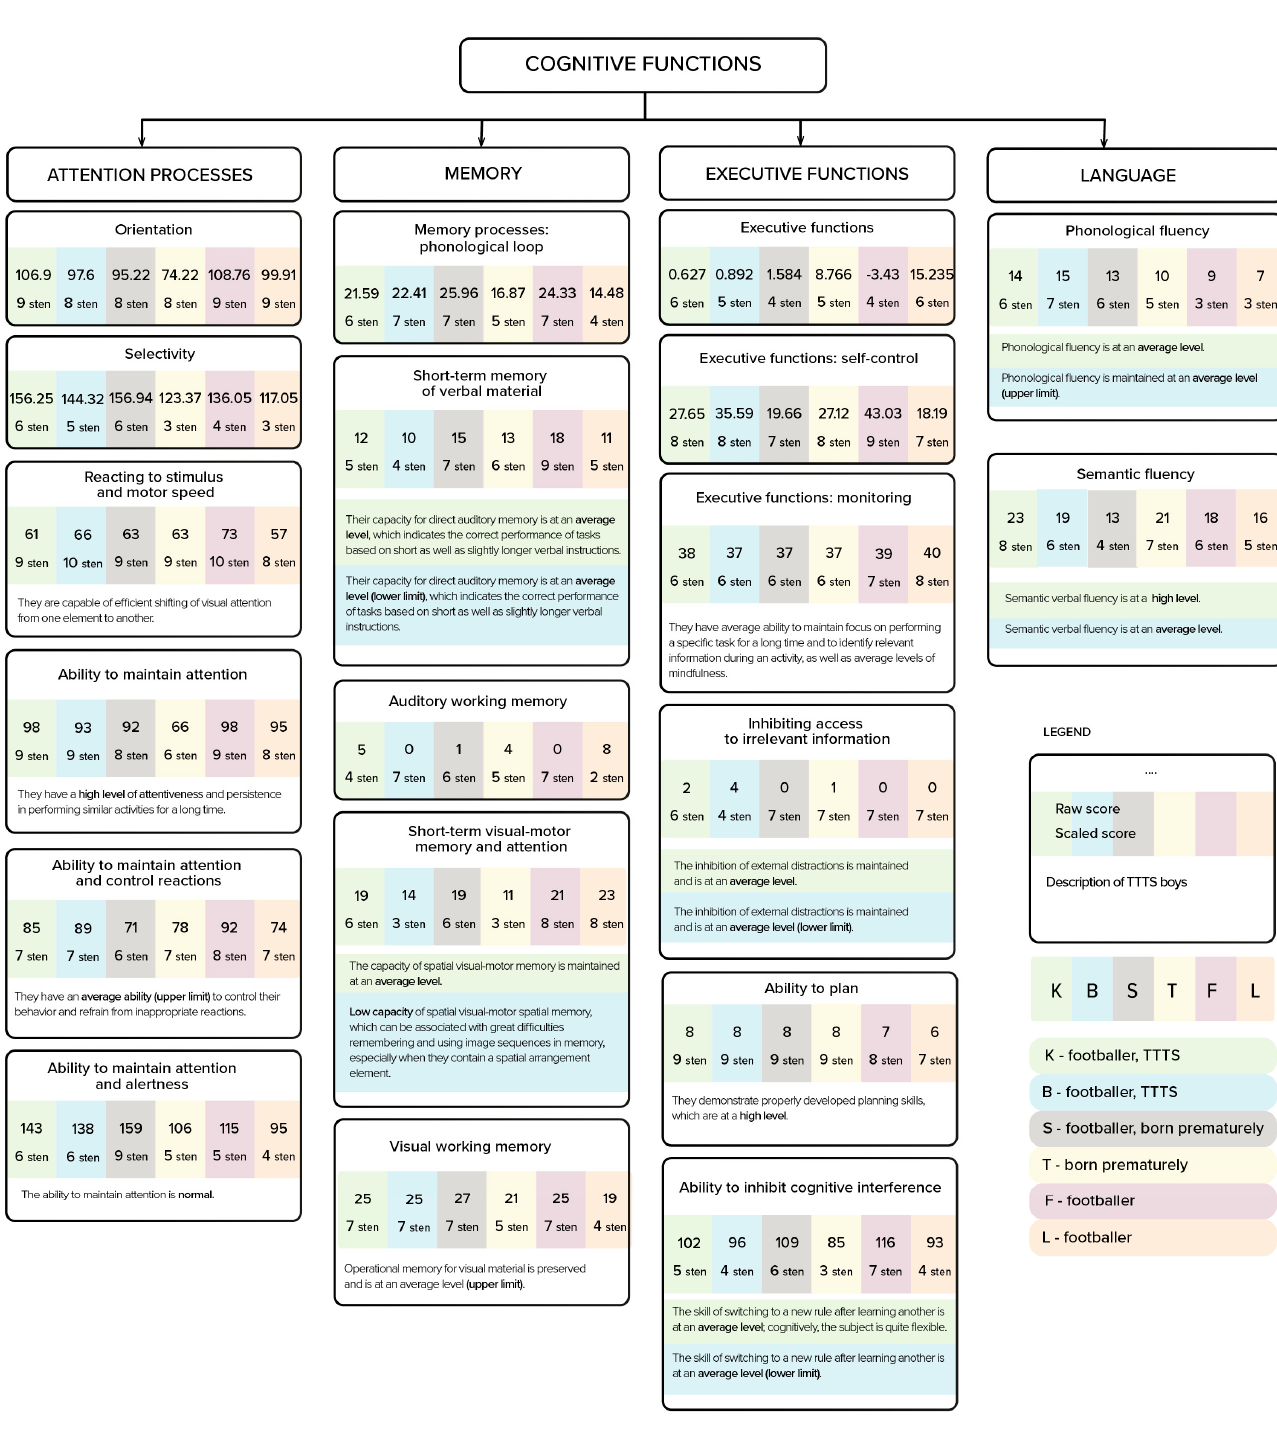
Figure 2. Profiles of cognitive functions.